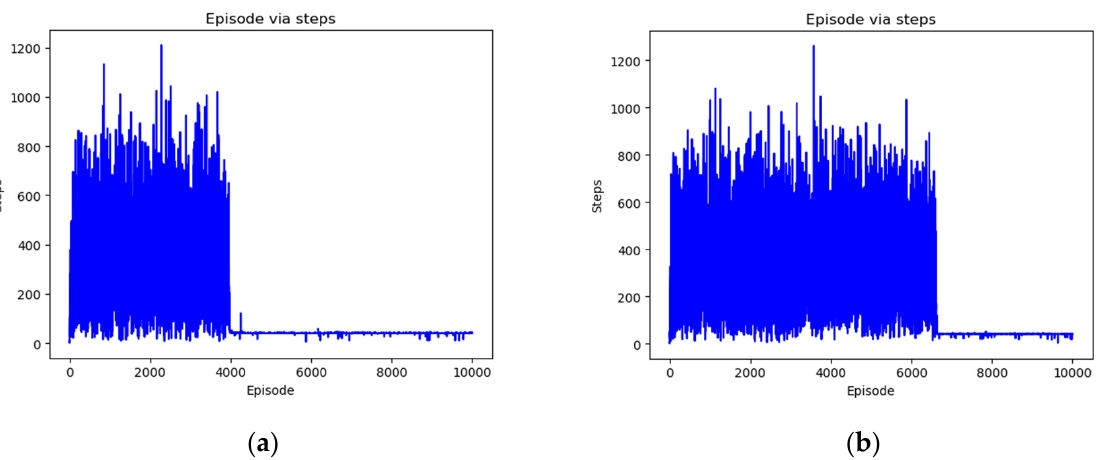
Figure 13. Graph of step changes during training. ( a ) No change in steps in the fire environment; ( b ) Change in steps in the fire environment.